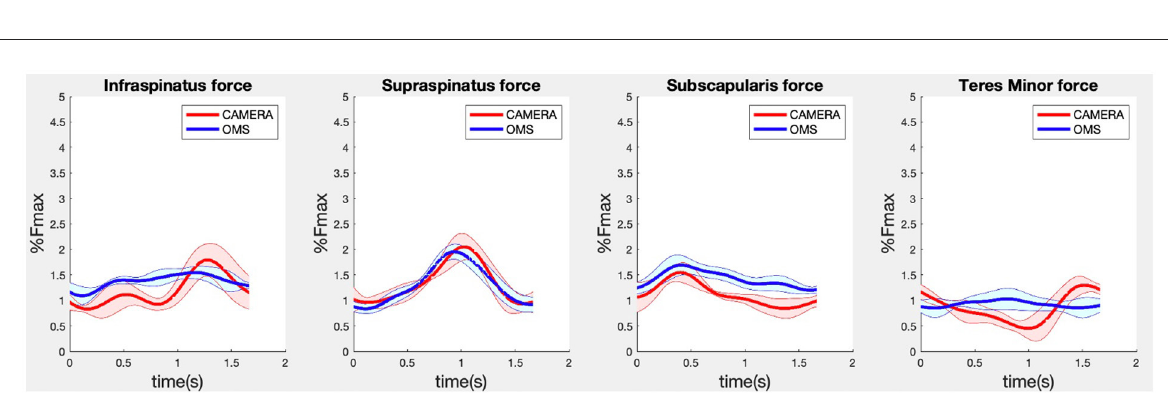
FIGURE6 Results for the rotator cuff muscle forces during the lateral fly exercise. Results obtained from OMS (blue) and camera (red) are presented as mean ± 1SD (shaded) over all participants.